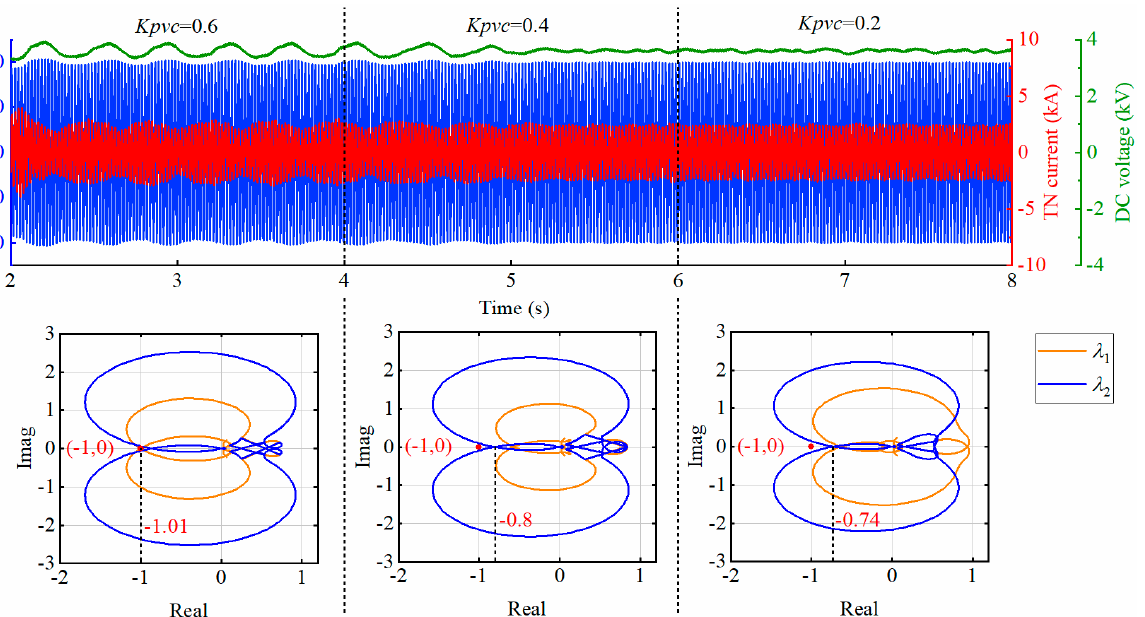
Figure 10. Simulation waveforms when the number of passenger locomotives is 8.